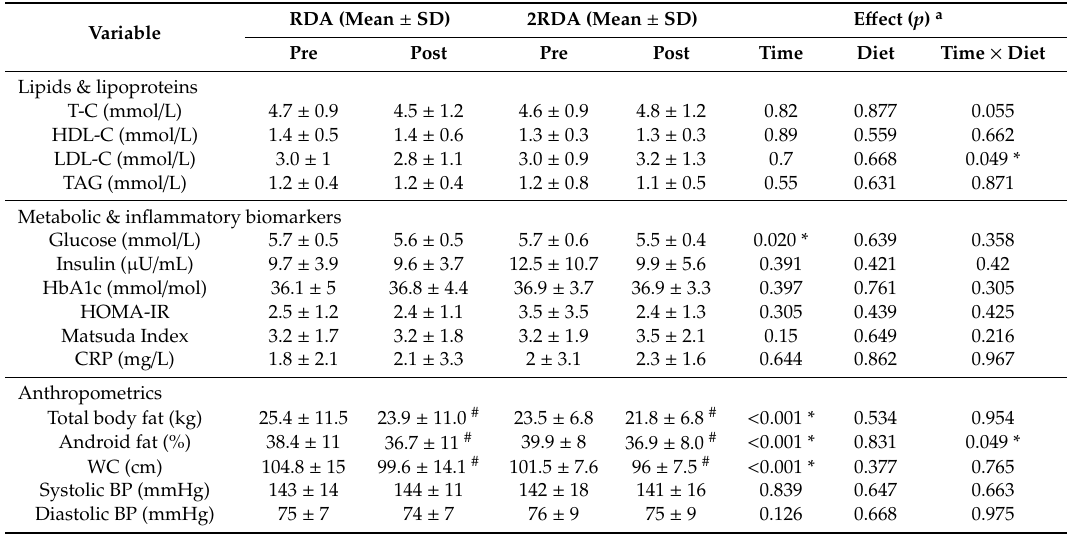
Table 3. Fasting measurements of circulatory cholesterol, triglycerides, glucose, insulin, CRP and anthropometric measurements of the RDA and 2RDA groups pre- and